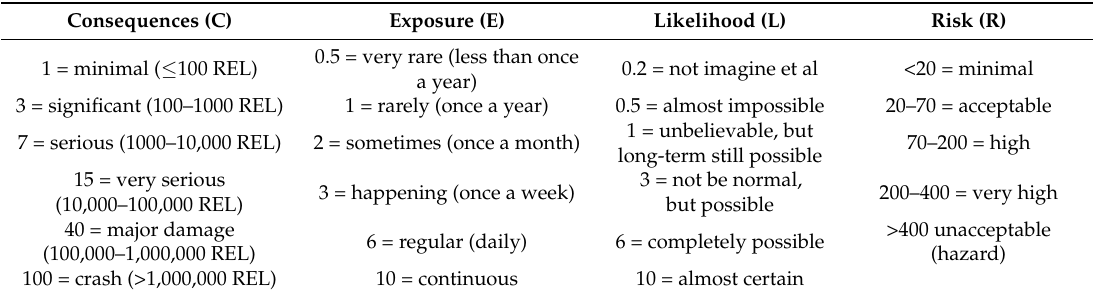
Table 2. The grades for Consequences (C), Exposure (E), Likelihood (L) and Risk (R) used in this